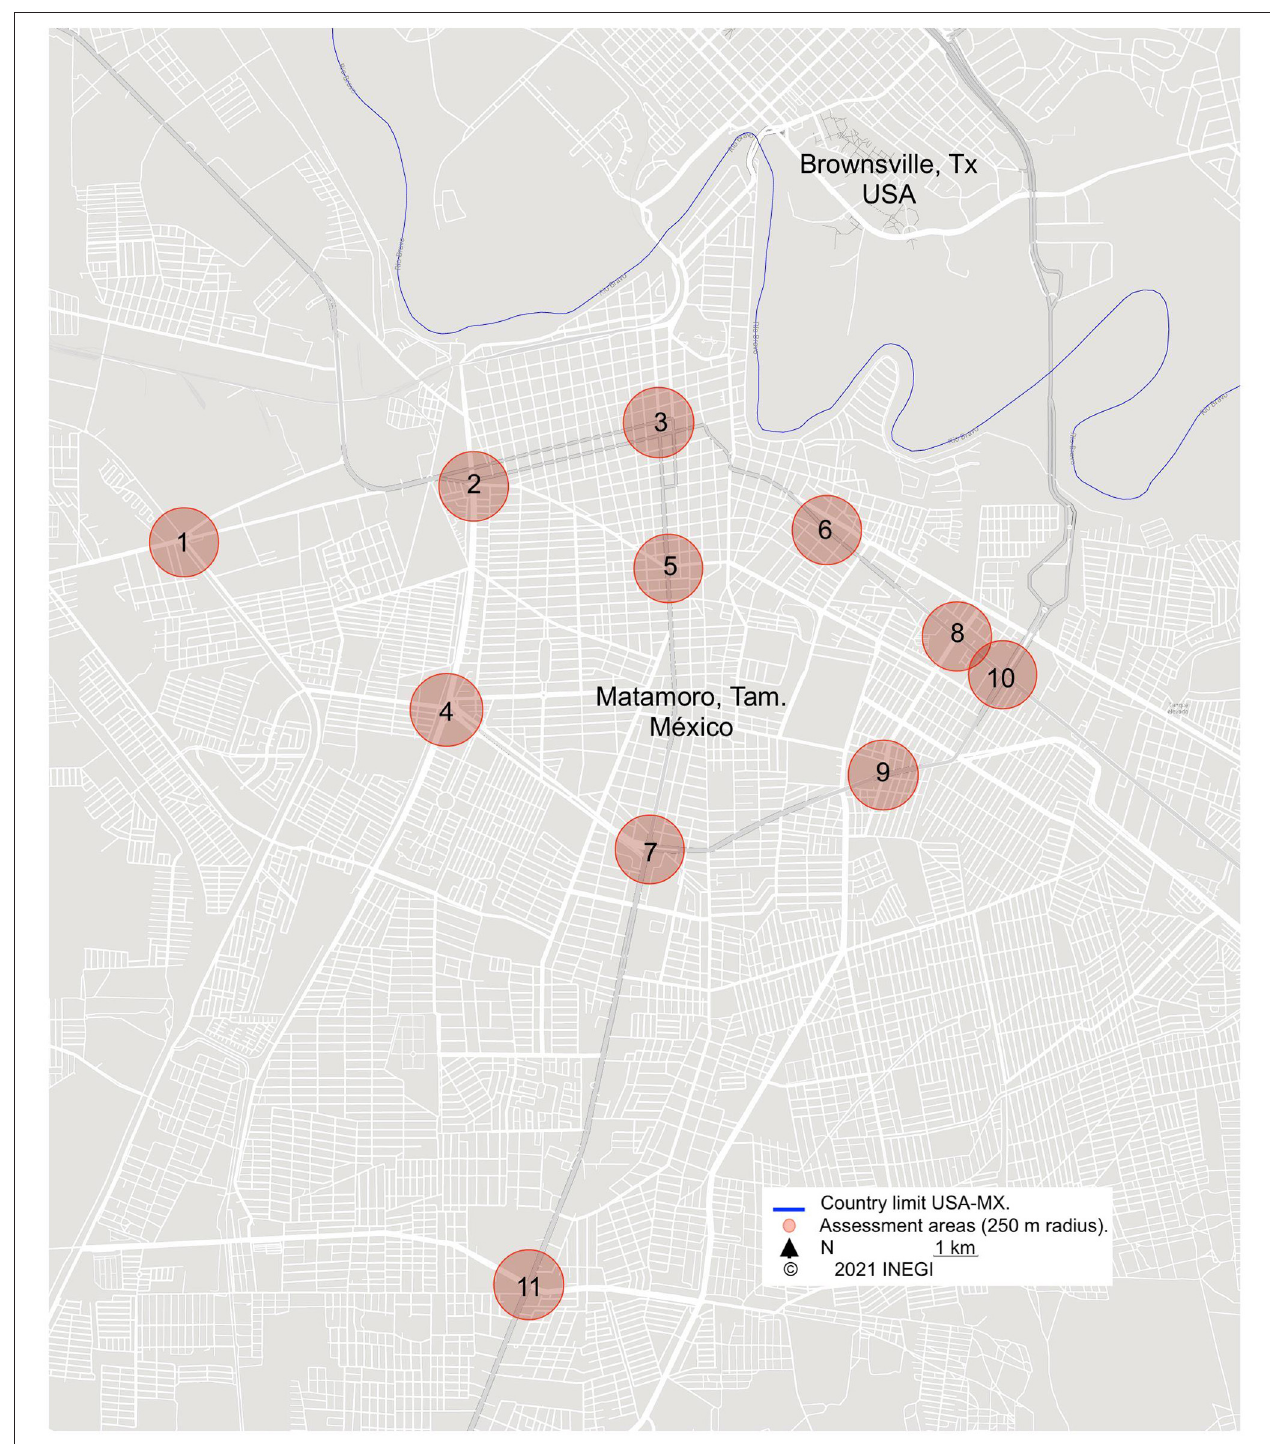
FIGURE 1 | Assessment areas.